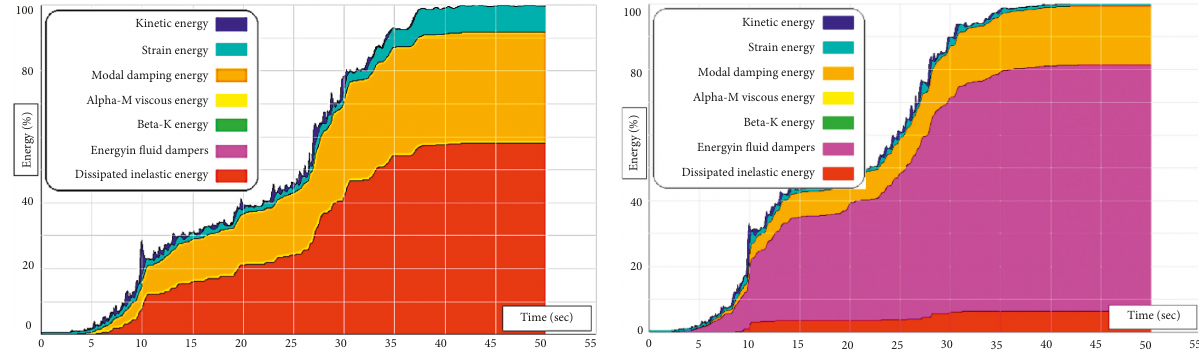
Figure 8: 12-story frame under record near Landers without and with dampers.